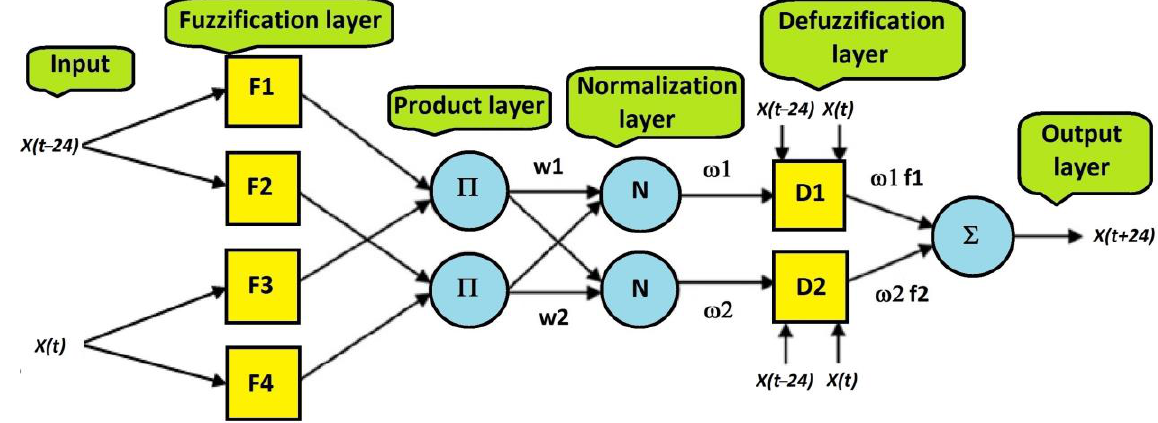
Figure 6. The architecture of the ANFIS model to the prediction of the output variable X(t + 24) taking into consideration two input variables X(t − 24) and X(t).